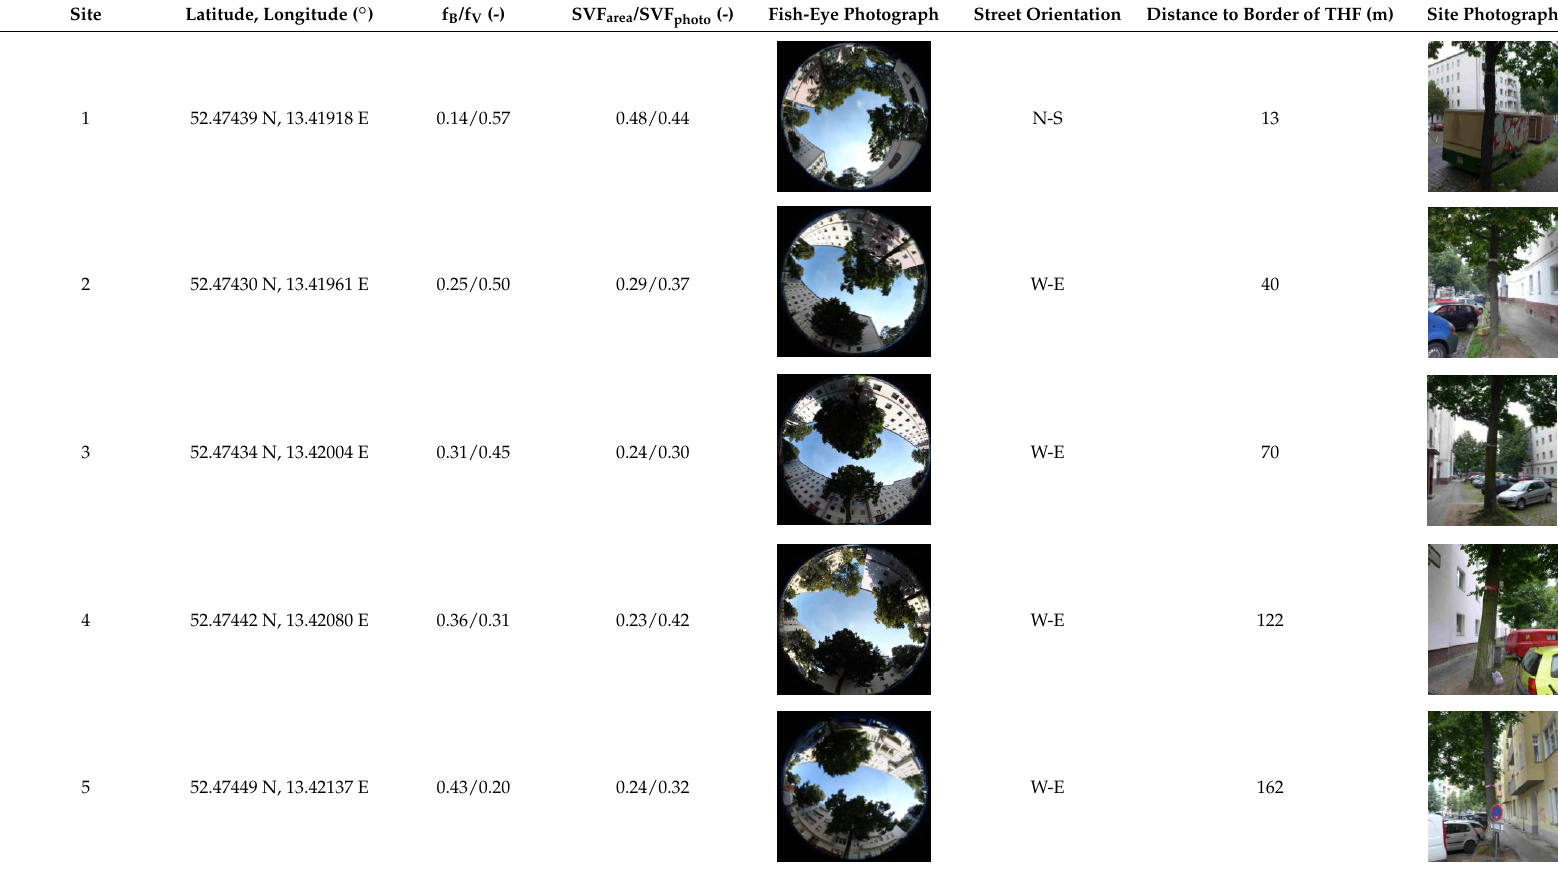
Table 2. Parameters describing the measurement sites in the study area Schillerkiez. Building surface fraction (f B ), vegetation surface fraction (f V ) and areal sky view factor (SVF area ) are given as spatial means for a 50 m radius around each site. SVF photo : sky view factor derived from fish-eye photographs. THF: former airport Berlin-Tempelhof.